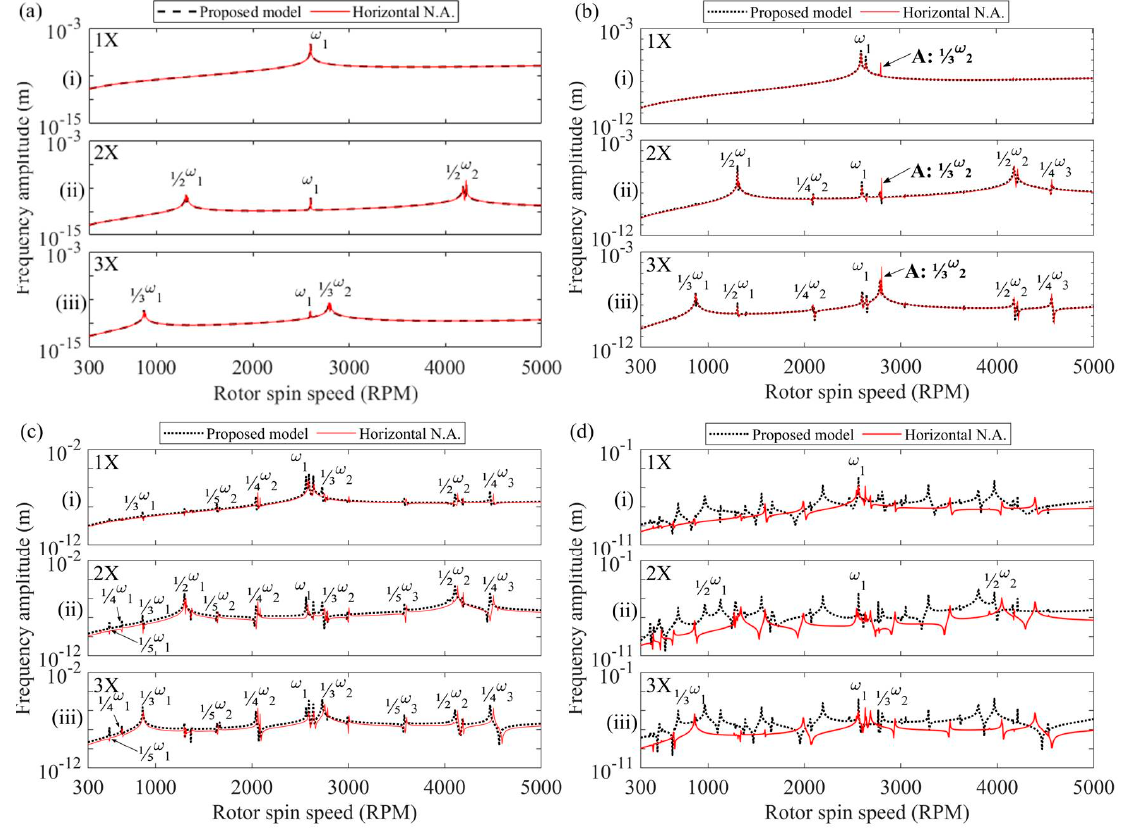
Figure 14. Vertical amplitude of the first three frequency components in the vicinity of the first critical speed: ( a ) non-cracked, ( b ) µ = 0.2, ( c ) µ = 0.5 and ( d ) µ = 0.8 for ( i ) 1X, ( ii ) 2X and ( iii ) 3X frequencies.